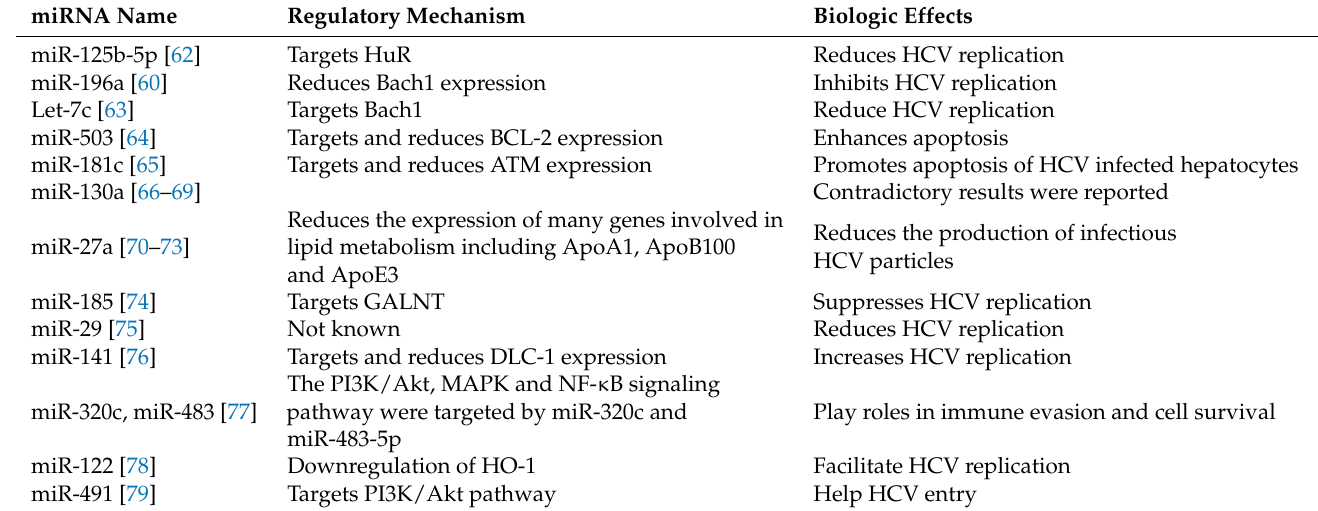
Table 3. miRNAs involved in HCV